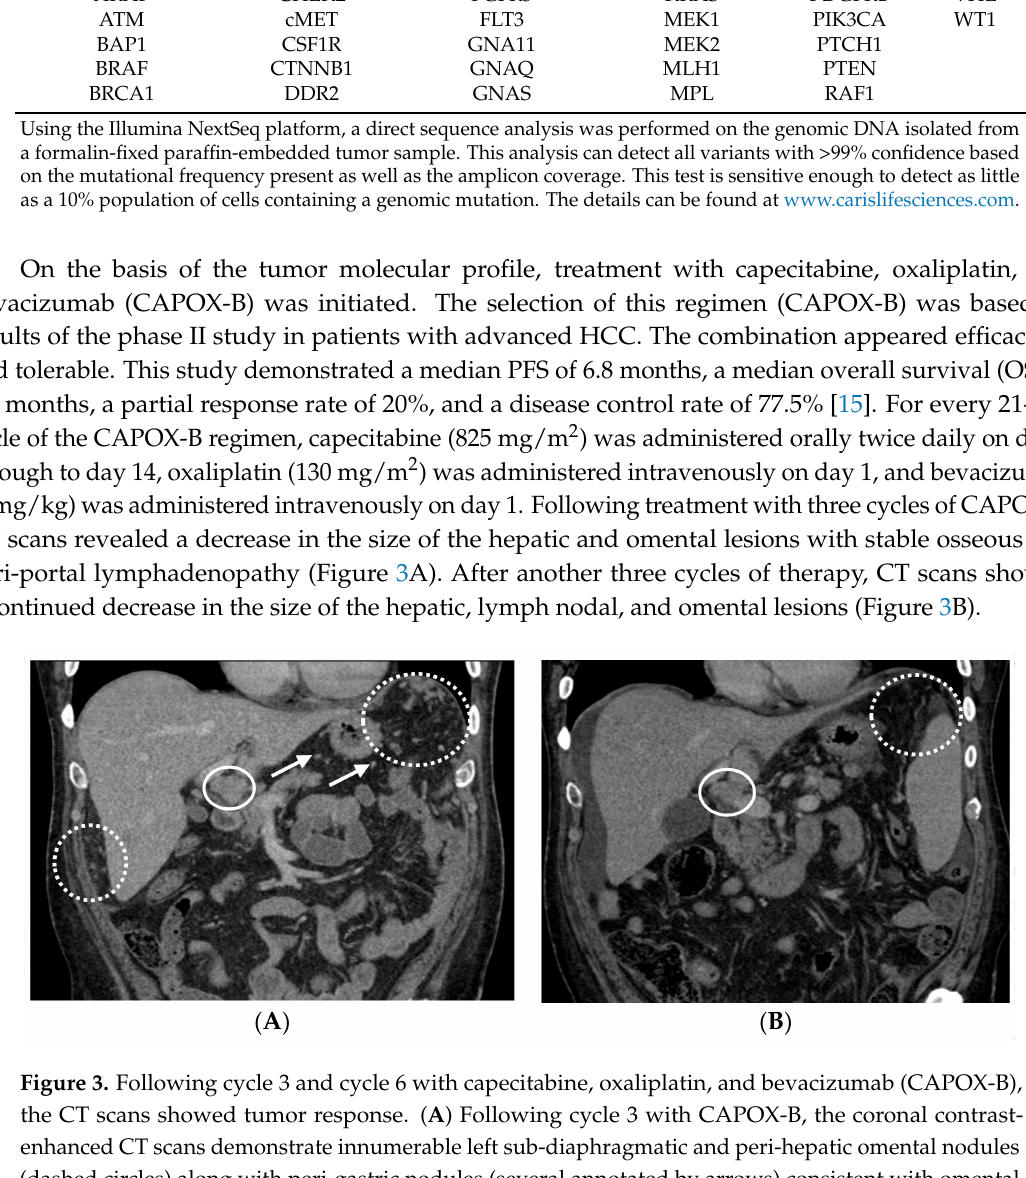
enhanced CT scans demonstrate innumerable left sub-diaphragmatic and peri-hepatic omental nodules (dashed circles) along with peri-gastric nodules (several annotated by arrows) consistent with omental carcinomatosis and mesenteric metastases. Peri-portal lymphadenopathy can be observed in the solid circle. ( B ) Following cycle 6 with CAPOX-B, the coronal contrast-enhanced CT scans demonstrate a decrease in omental metastases (dashed circle) and peri-portal lymphadenopathy (solid circle), and a small amount of peri-hepatic